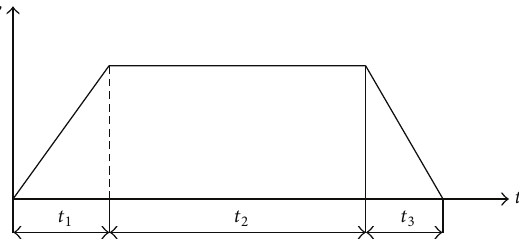
Figure 23: Underwater vehicle set speed curve.